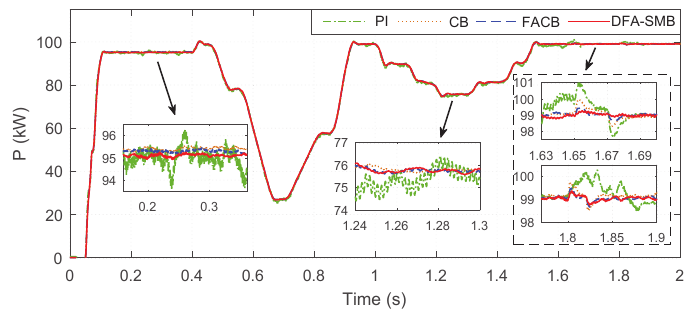
Figure 7. Active power curves under different